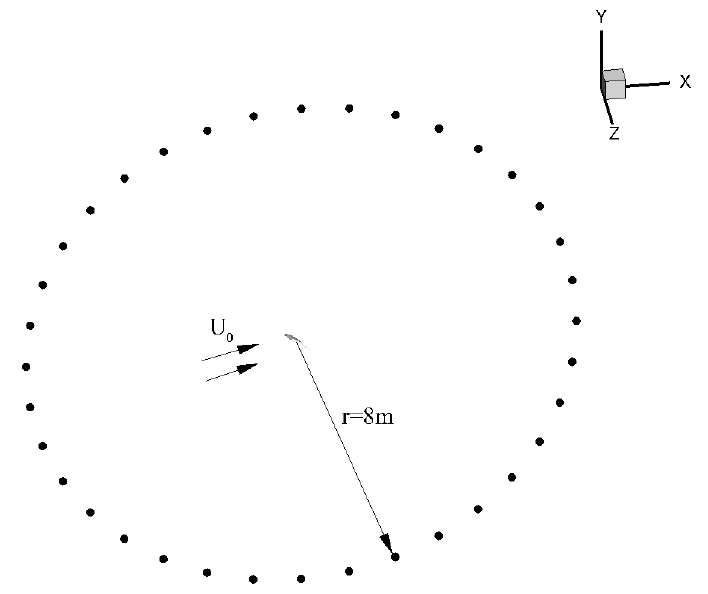
Figure 14. The locations of the far-field microphones.